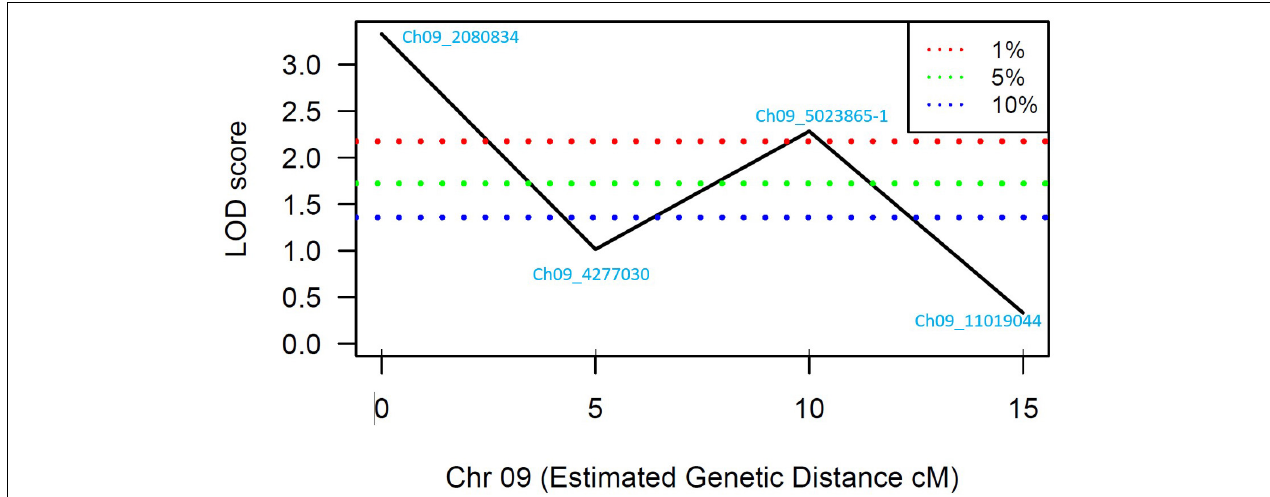
FIGURE 2 | LOD scores for the four SNP markers genotyped in the individuals constituting the resistant and susceptible bulks. The blue, green, and red dotted lines represent 90, 95, and 99% confidence intervals, respectively.